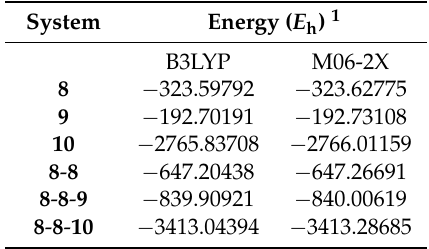
Table 2. DFT energies for the minimized